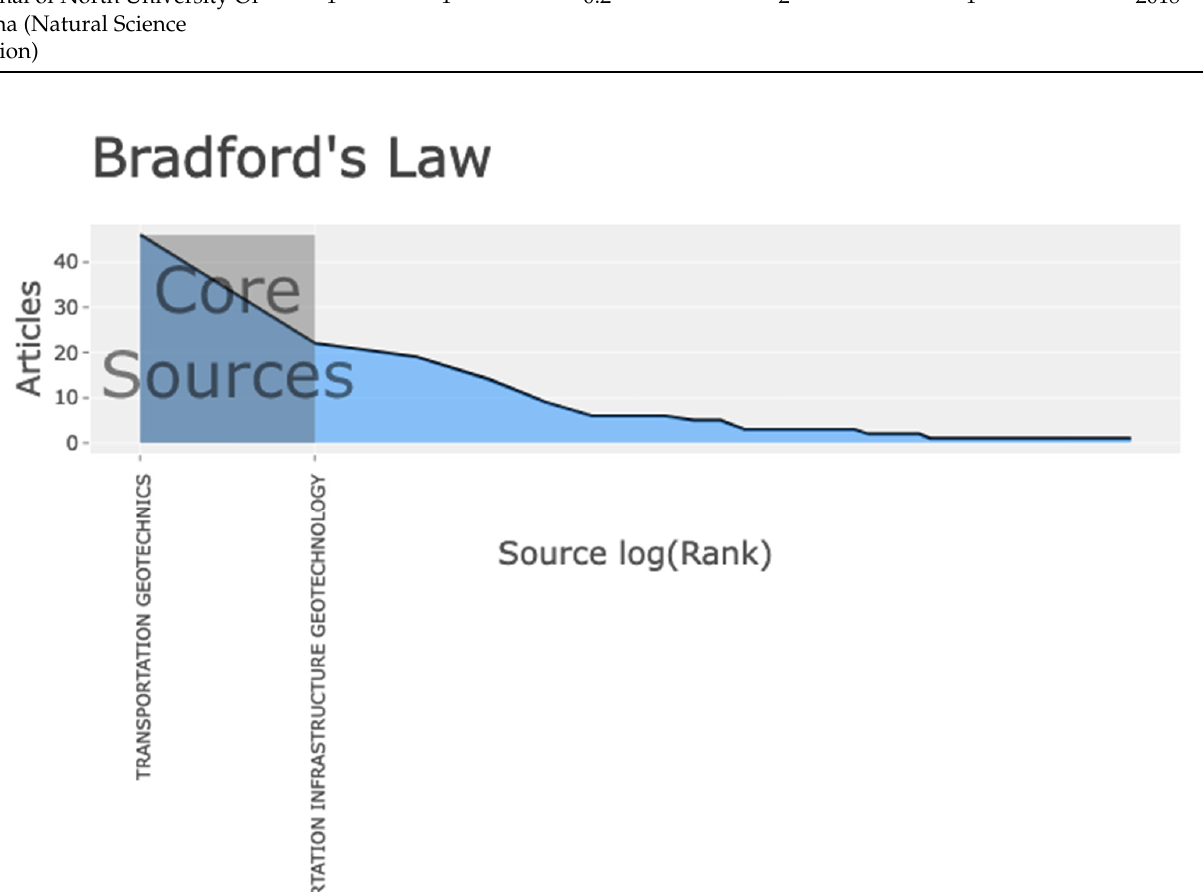
Figure 14. Core (ranked) publication sources. Table 9. Source clustering through Bradford’s Law.